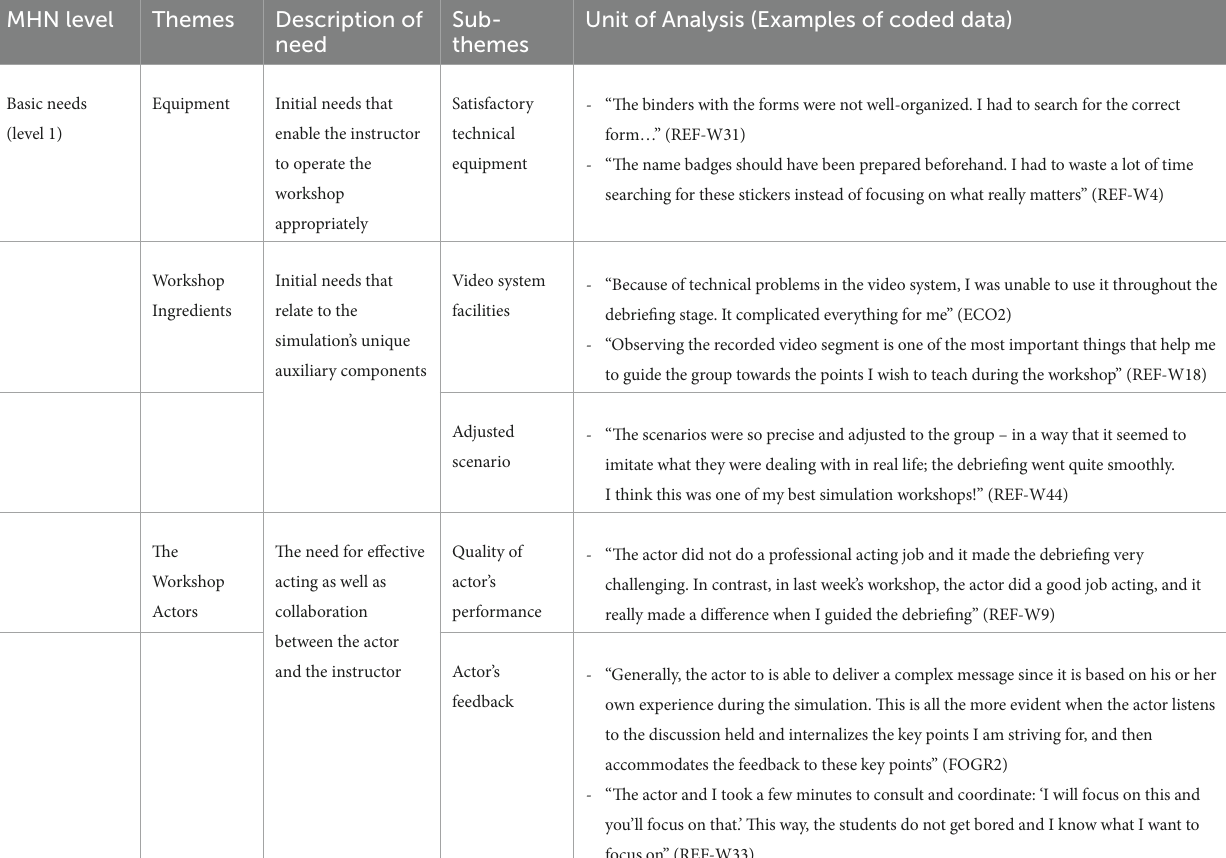
TABLE 2 A demonstration of the coding process using qualitative content analysis: An example of instructors’ needs that correspond to MHN-level 1, Basic Needs. MHN